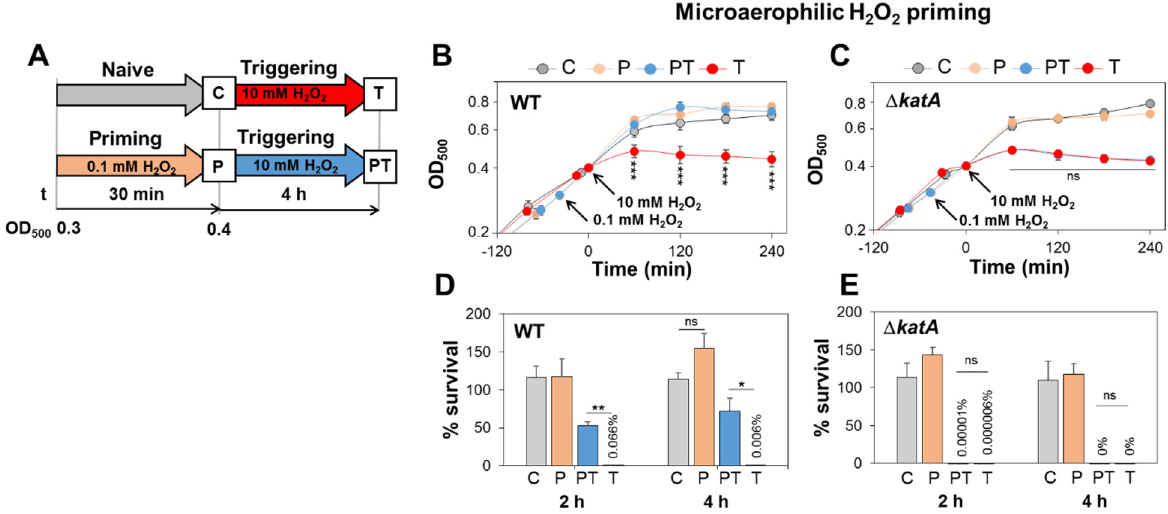
Figure 3. Microaerophilic H 2 O 2 priming confers improved resistance against otherwise lethal H 2 O 2 , which depends on KatA. ( A ) Setup for microaerophilic priming and triggering experiments. The S. aureus WT and ∆ katA mutant strains were grown microaerophilically and primed during the log phase with 0.1 mM H 2 O 2 for ~30 min (P), followed by treatment with 10 mM H 2 O 2 as a triggering stimulus (PT). The growth curves ( B , C ) and survival rates ( D , E ) were measured in naïve ( C ), primed (P), primed and triggered (PT) and triggered-only bacteria (T). The survival rates were calculated after 2 and 4 h of H 2 O 2 stress relative to untreated control cells. The results are from three to four biological replicates. Error bars represent the SD. The statistics were calculated using Student’s unpaired two-tailed t -test in Graph Prism. Symbols: ns p > 0.05, * p < 0.05, ** p ≤ 0.01 and *** p ≤ 0.001.